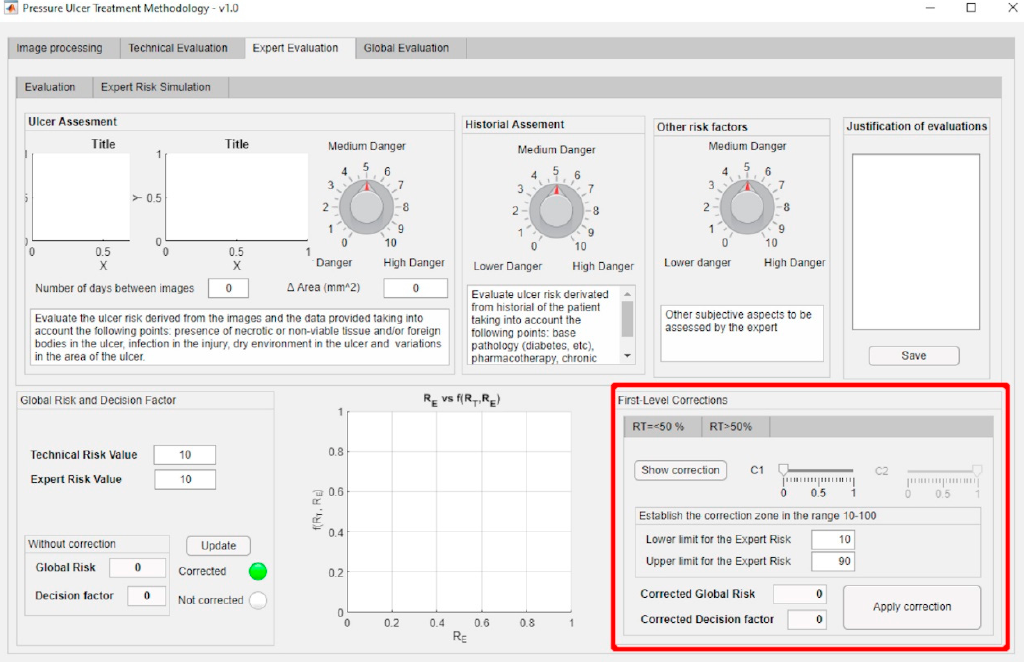
Figure 13. First-level corrections panel.